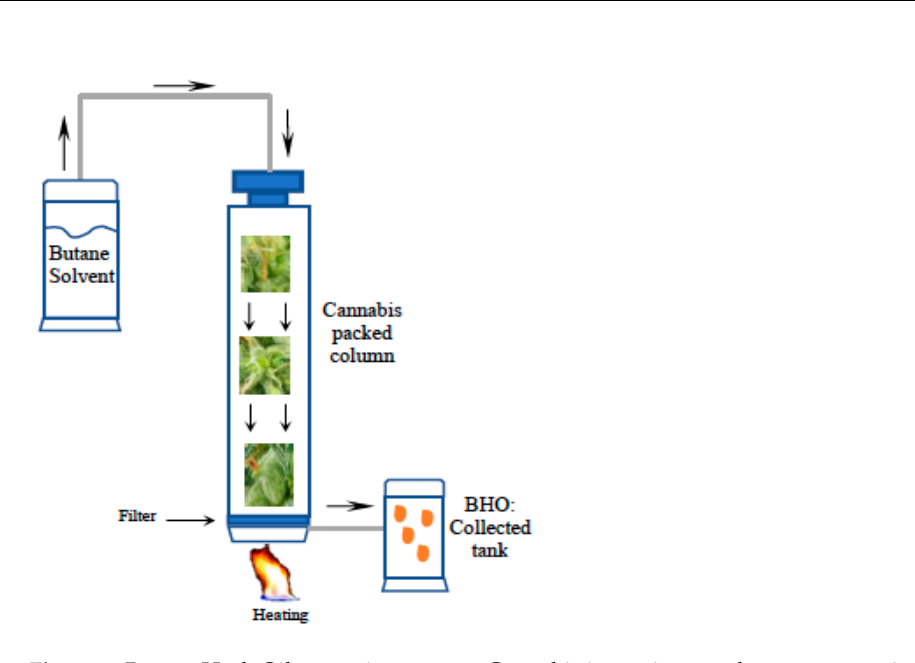
Figure 2. Butane Hash Oil extraction system. Cannabis in put into a column or extraction cylinder and butane solvent is passed through, heated a low temperature to extract terpenes and cannabinoids. The extract is then filtered and recovered into a new cylinder.